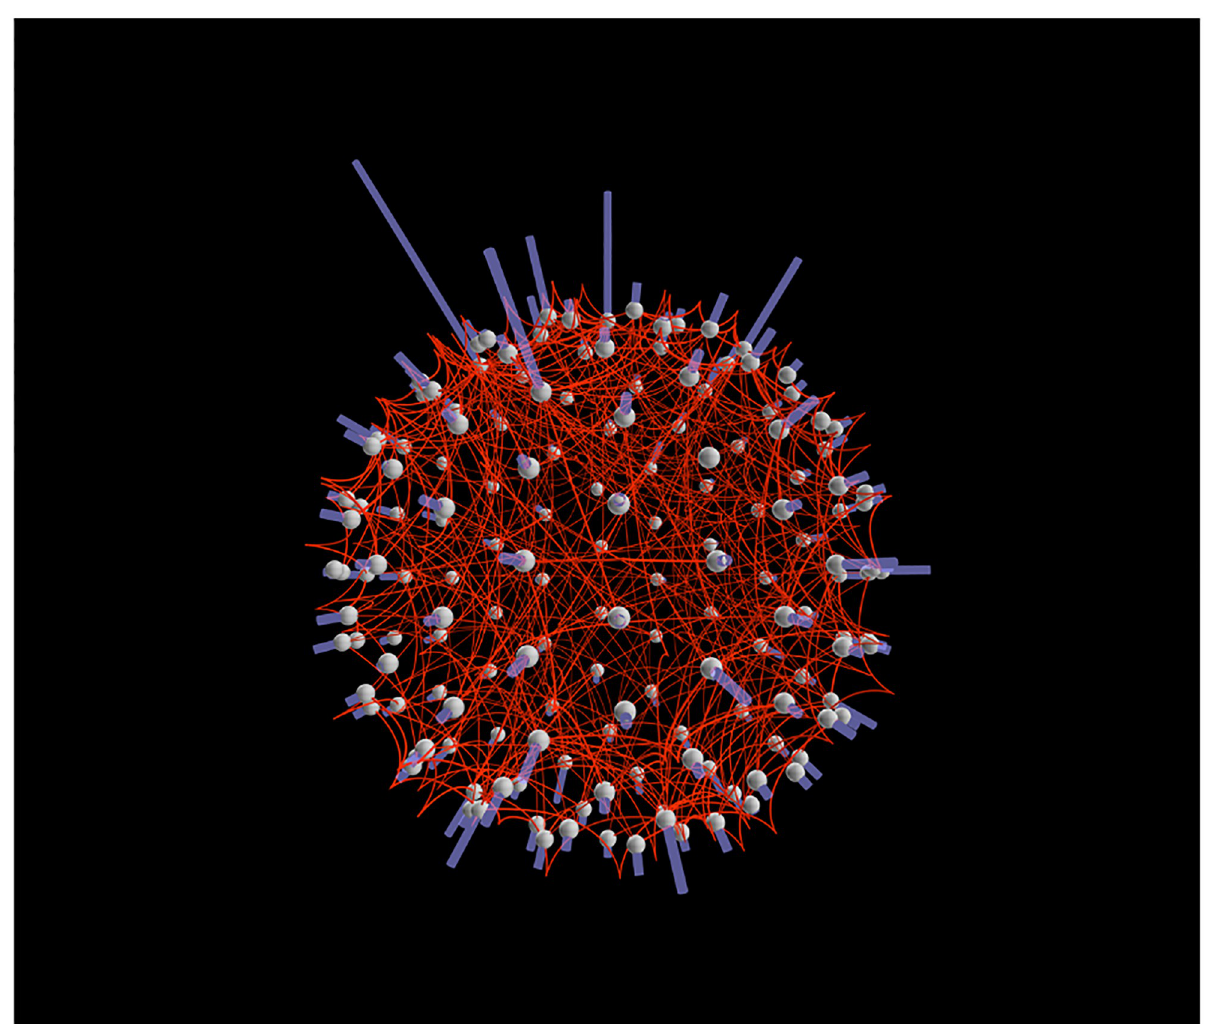
Fig 5. Representation of the node degrees. In this synthetic network, nodes are homogeneously distributed on a sphere. Links are established via a Barabasi-Albert model. Node degrees are illustrated as vertical bars perpendicular to the surface of the nodes. The network visualization has been generated with Vizaj using a Peak shape for the